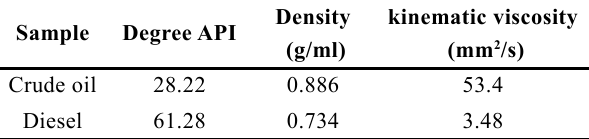
Fig.1. The pulse sequence used for the DOSY and T Table1. API degree, density and kinematic viscosity (all at 25 °C) of the crude oil and the diesel samples used in this study.